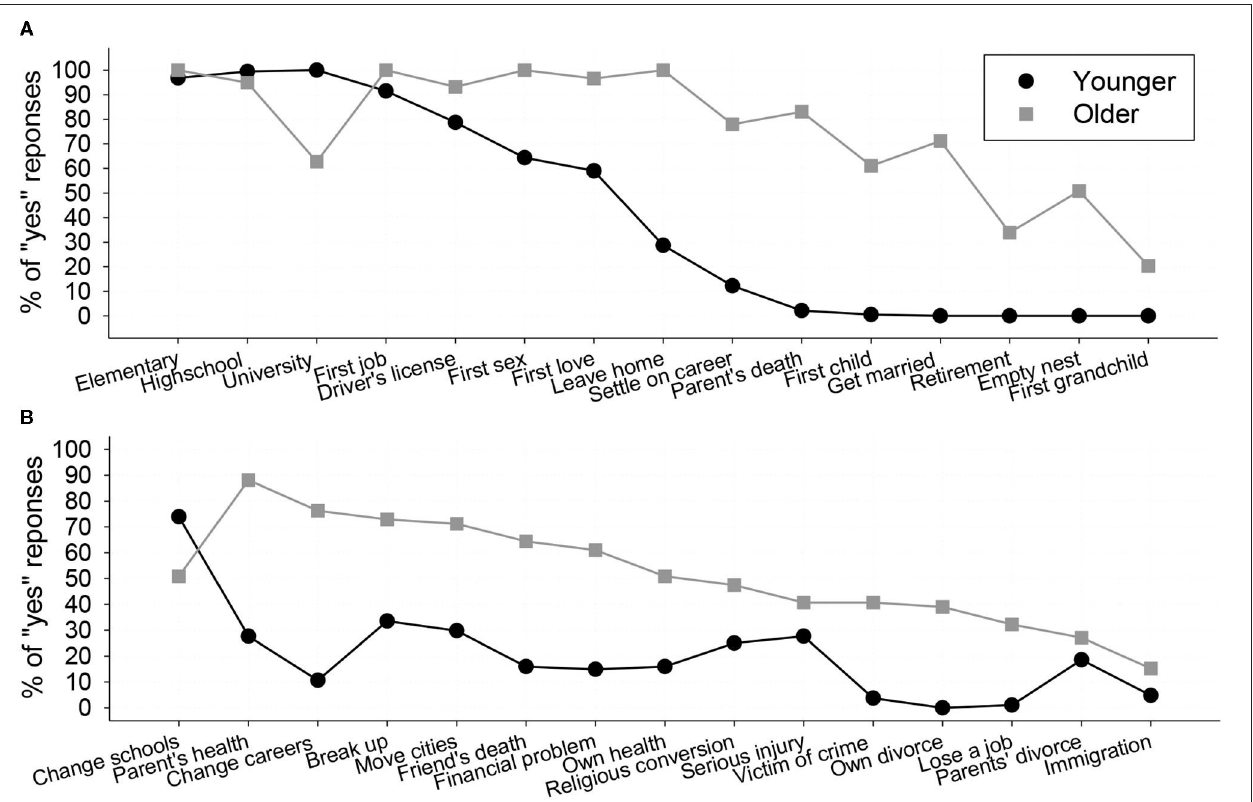
FIGURE 1 | The prevalence of personally experienced script-consistent events (A) and script-divergent events (B) in the younger and older